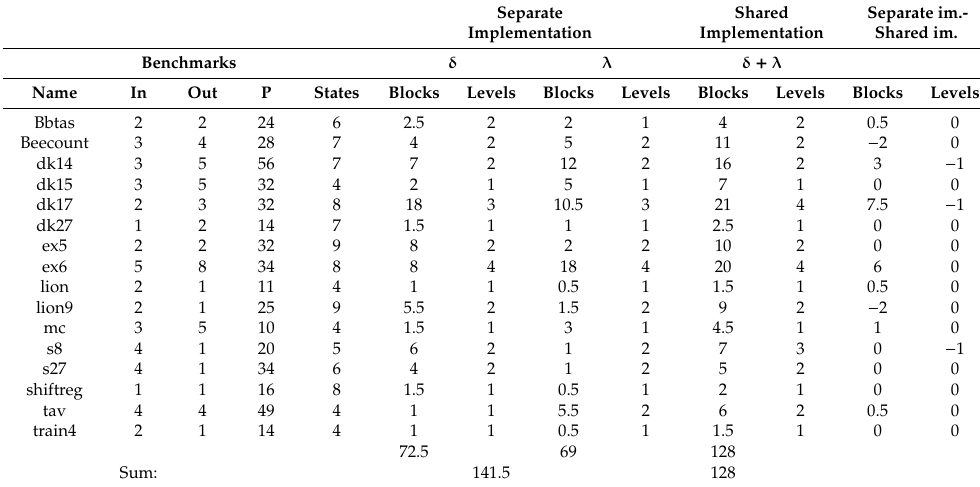
Table 3. Results of experiments (DECOMP, number of states < 10).